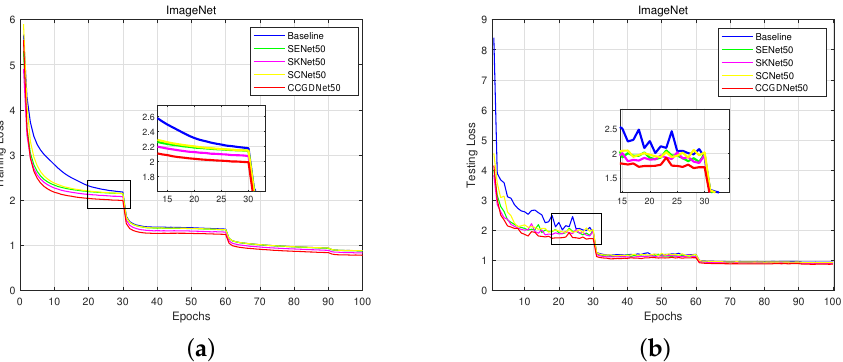
Figure 5. The loss curves of using different attention-based methods on ImageNet dataset with ResNet50: ( a ) training loss; ( b ) testing loss.